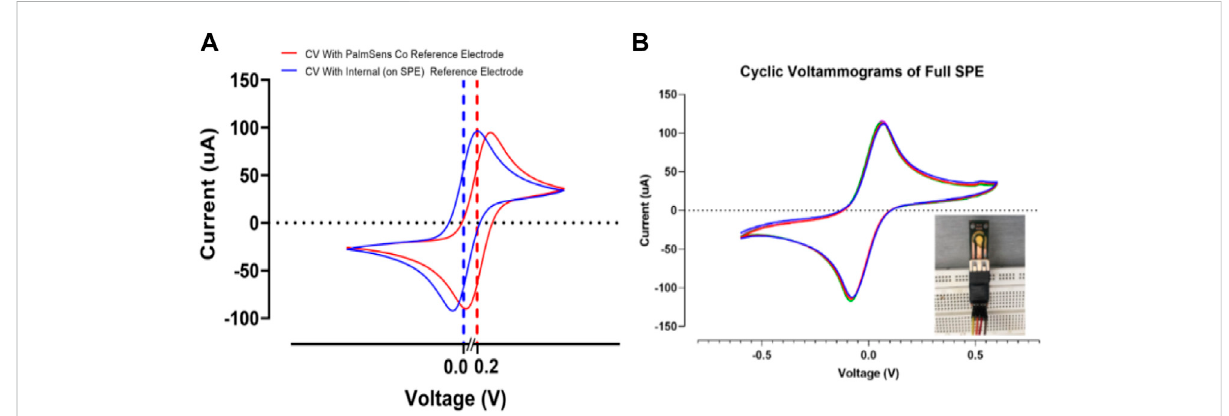
FIGURE 10 (A) Evaluating the effect of the internal and external reference electrodes on SPEs response. (B) Cyclic voltammograms of the full SPE with internal reference electrode for 10 cycles. All voltammograms were recorded in 0.5 mM K 4 Fe(CN) 6 /K 3 Fe(CN) 6 at 50 mV s − 1 .